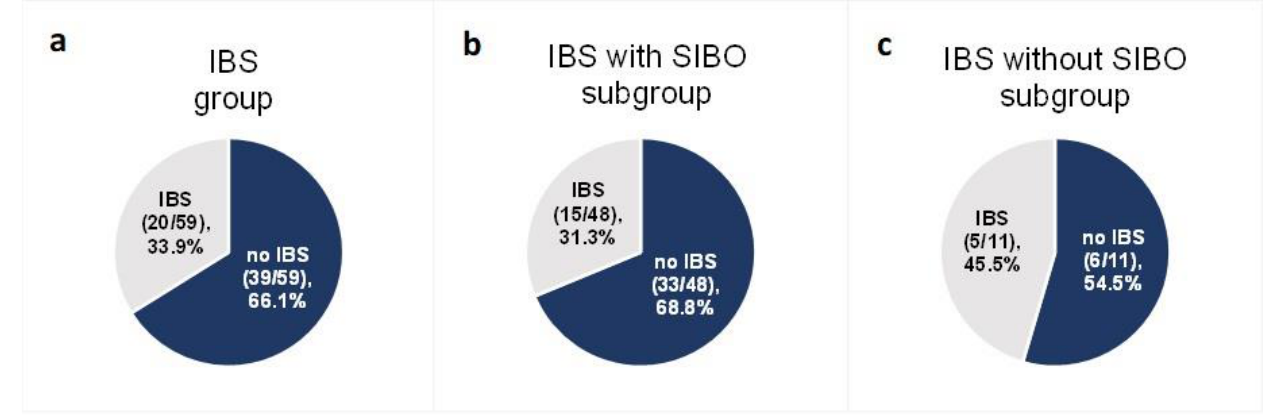
Figure 4. Proportion of patients with IBS-like symptoms after the low-FODMAP dietary intervention in the group with IBS at baseline ( a ) and in the two IBS subgroups: with SIBO at baseline ( b ) and without SIBO at baseline ( c ).